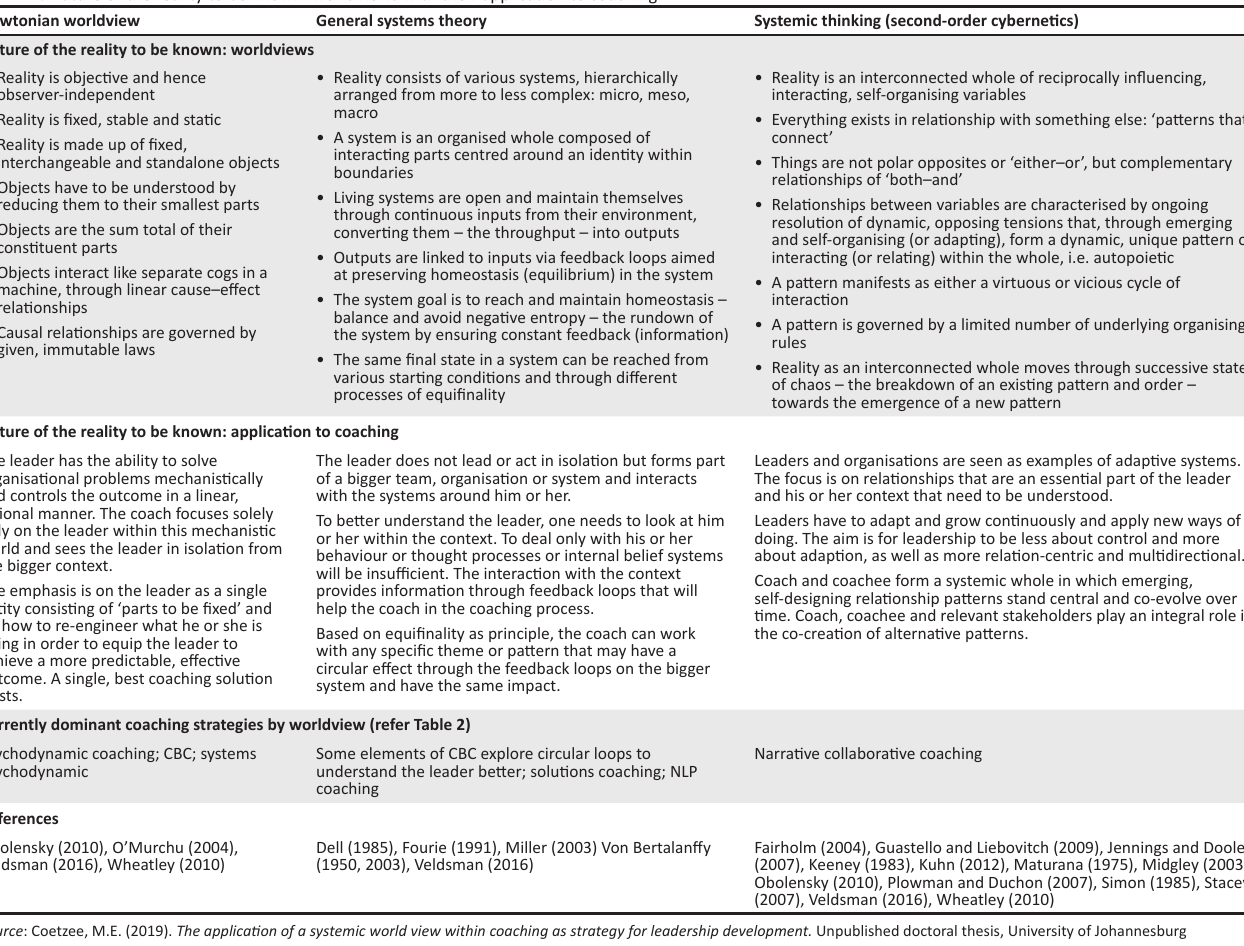
Table 4 addresses the third worldview theme: the process of knowing and the features of a sound knowing process.